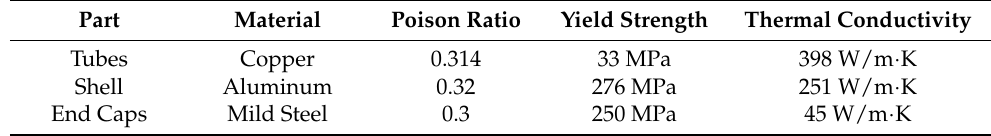
Table 3. Properties of the selected materials used in numerical